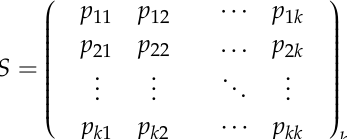
Figure A4. Exemplary subset of the technology space